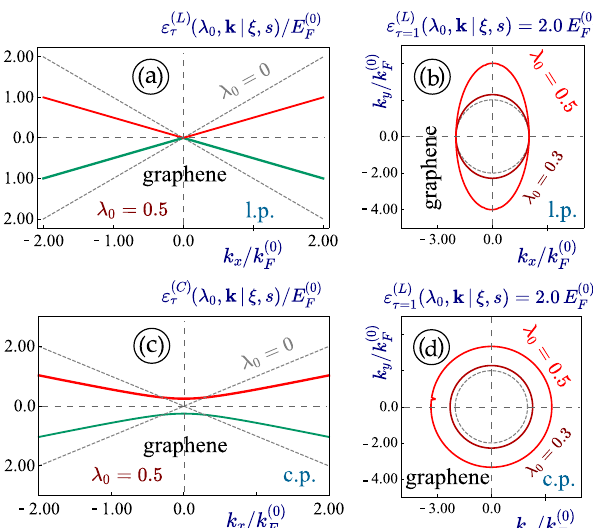
Figure 10. (Color online) Energy dispersions for irradiated graphene -like simplification of 1T ′ -MoS 2 Hamiltonian in Eq. (1). In particular, we set V graphene energy spectrum in Eq. (3). Panels ( a ), ( b ) demonstrate the effect of a linearly-polarized dressing field on such a material, while panels ( c ), ( d ) are associated with a circularly-polarized irradiation. In contrast to familiar dispersion plots ε τ ( (cid:31) 0 , k ) [in ( a ), ( c )], panels ( b ), ( d ) present a constant-energy cut [ ε τ ( (cid:31) 0 , k ) of two degenerate electron-like energy subbands corresponding to τ